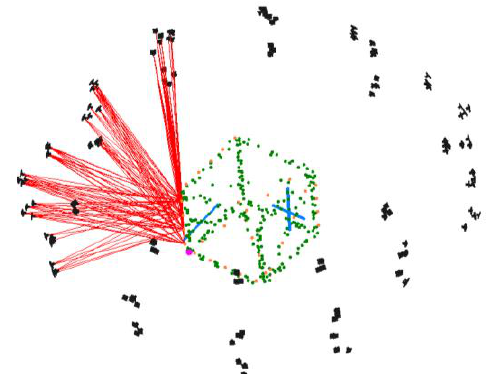
Figure 5. Scheme of image bundle for accuracy evaluation test according to VDI/VDE 2634.1 (2002)